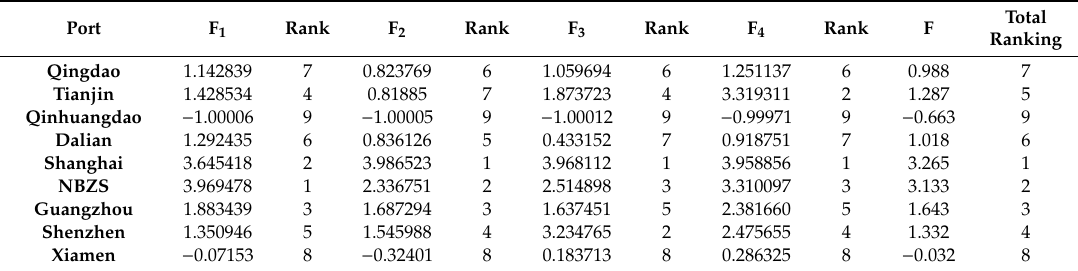
Table 7. Factor score table of each